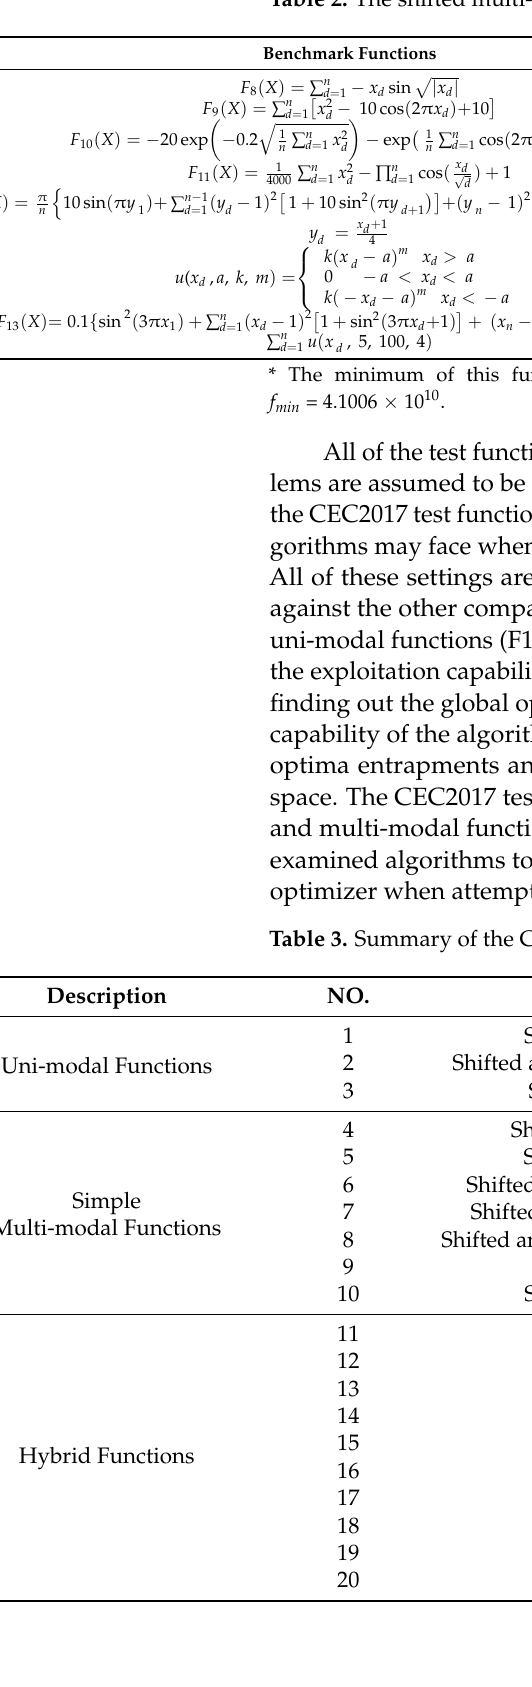
Table 2. The shifted multi-modal benchmark functions.